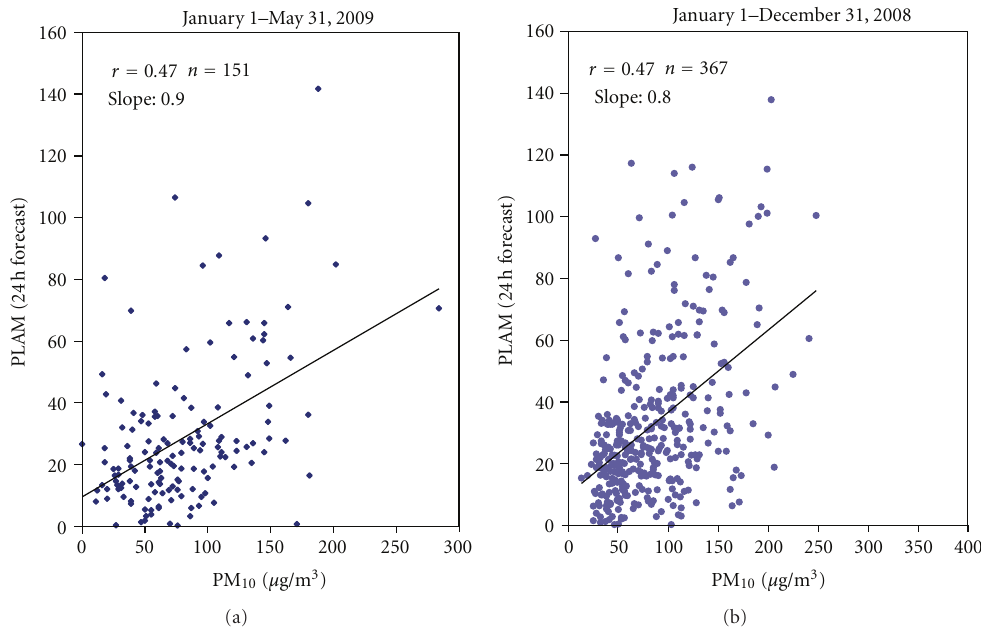
Figure 8: Correlation analysis between PLAM 24h prediction and PM 10 January 1–December 31, 2008 in Shanghai (a) and correlation analysis between PLAM 24 h prediction and of PM 10 January 1–May 31, 2009 in Guangzhou